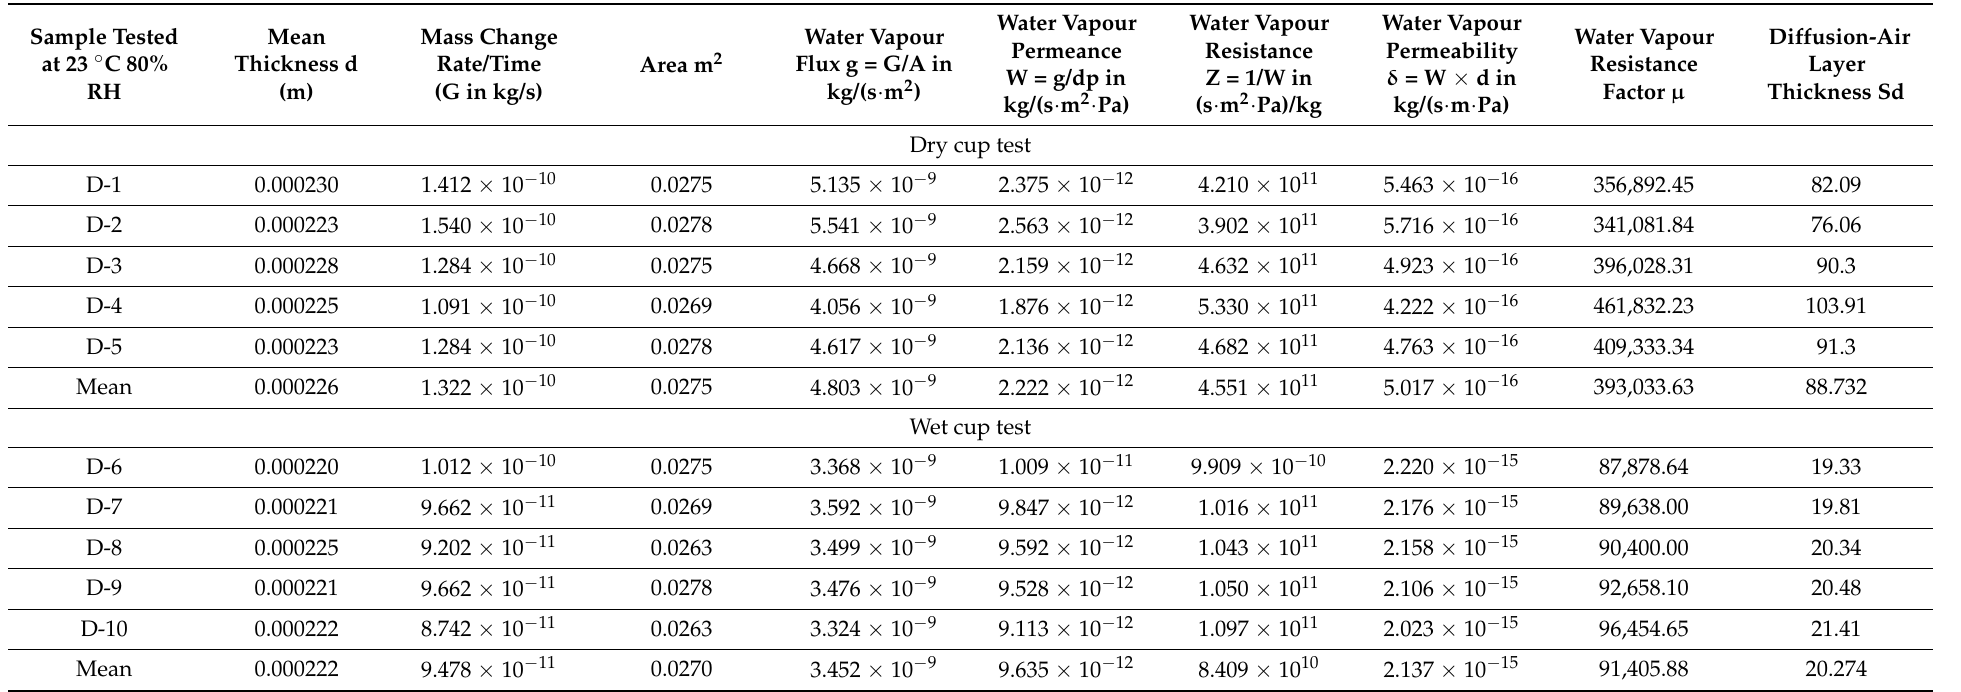
Table A9. Water vapour resistivity properties for sample D at 23 ◦ C 80%